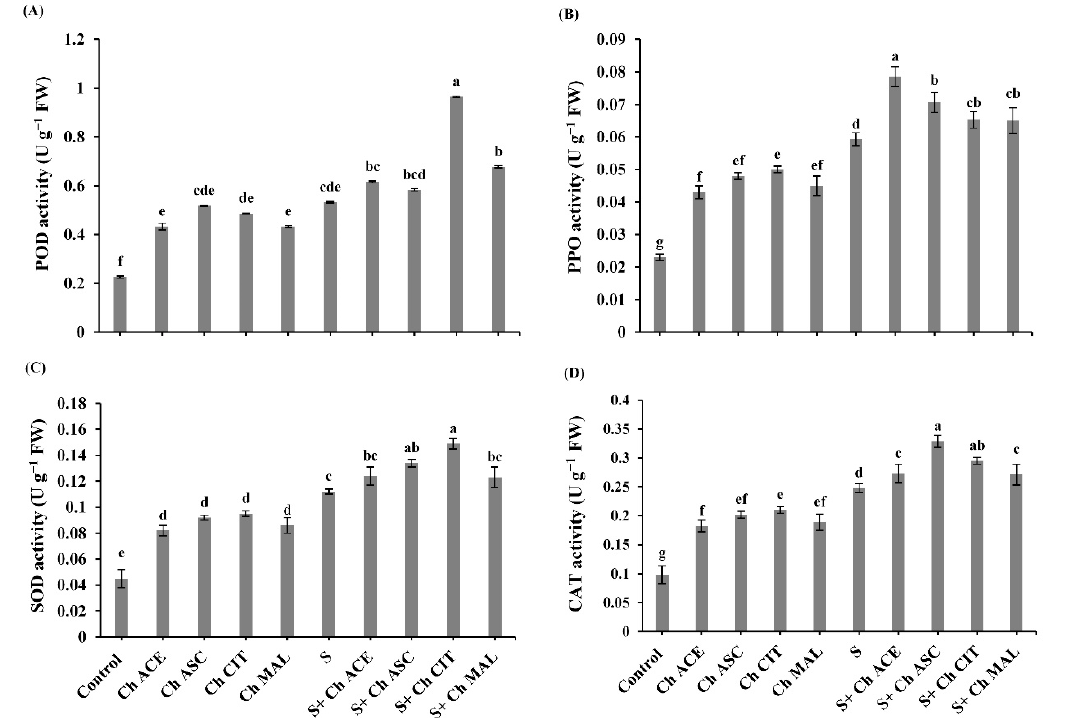
Figure 6. Effect of salinity (S) and foliar application of chitosan dissolved in different organic acids (Ch ACE, Ch ASC, Ch CIT and Ch MAL) and their interactions on ( A ) Peroxidase (POD) activity, ( B ) Polyphenol oxidase (PPO) activity, ( C ) Superoxide dismutase (SOD) activity and ( D ) Catalase (CAT) activity of tomato plants. Data are presented as means ± SE (n = 3). Data followed by different letters are significantly different following Tukey’s honestly significant difference (HSD) test at P ≤ 0.05. FW: fresh weight.